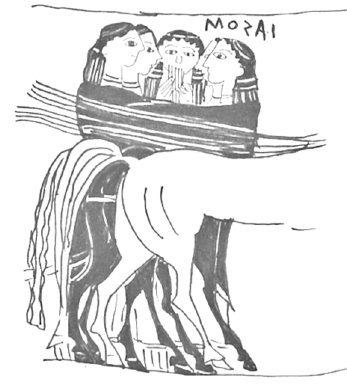
Figure 8. The Muses. Black-figured dinos (Attic). British Museum 1971, 1101.1. Signed by Sophilos. Ca. 580 BCE. Drawing by the author.